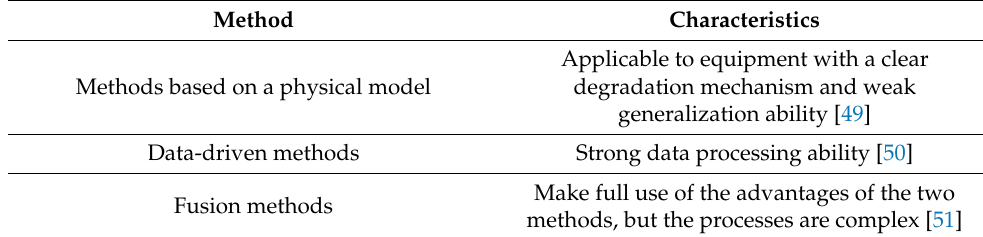
Table 4. Characteristics of remaining life prediction methods.